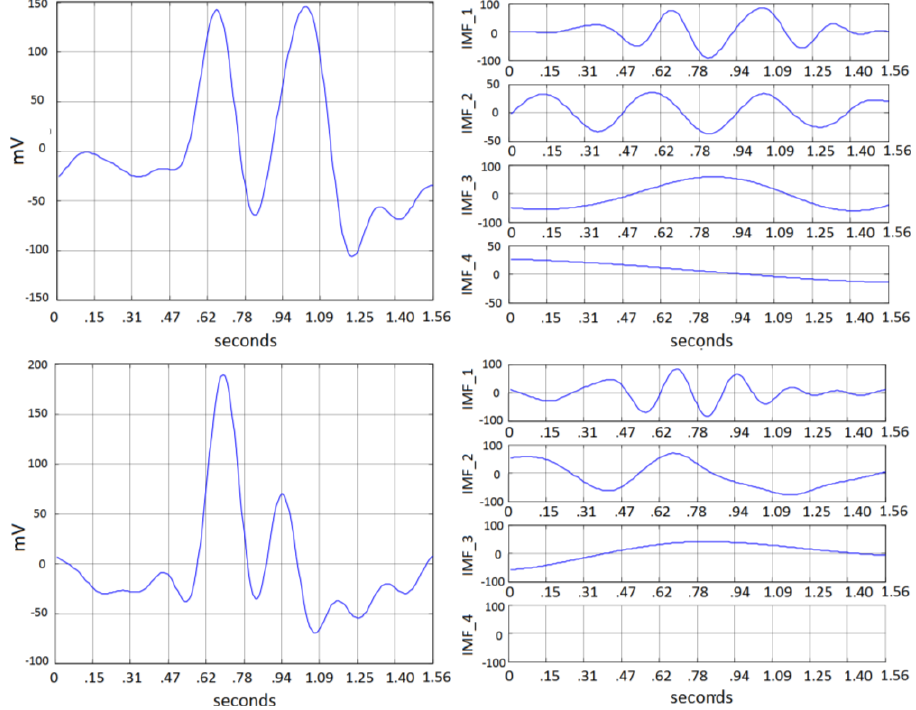
Figure 14. Typical EMD decompositions ( Right ) for blinking events ( Left ) from two different subjects under